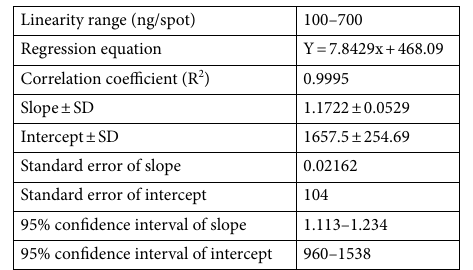
Table 1. Linear regression data for the calibration curve of SLD (n = 6).